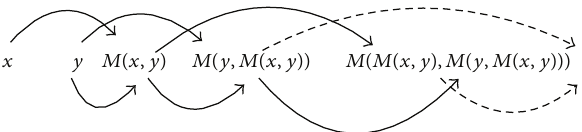
Figure 2: Another way of iterating a pair of initial conditions (𝑥,𝑦) under a bilinear operator 𝑀 : 𝑋 × 𝑋 → 𝑋